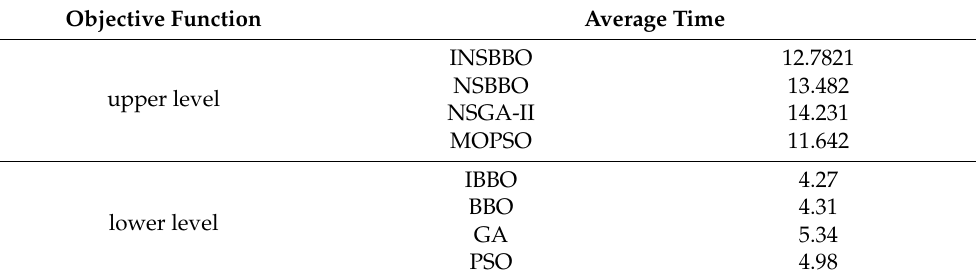
Figure 16. Comparison of IBBO and BBO solving the lower objective function in different time domains.